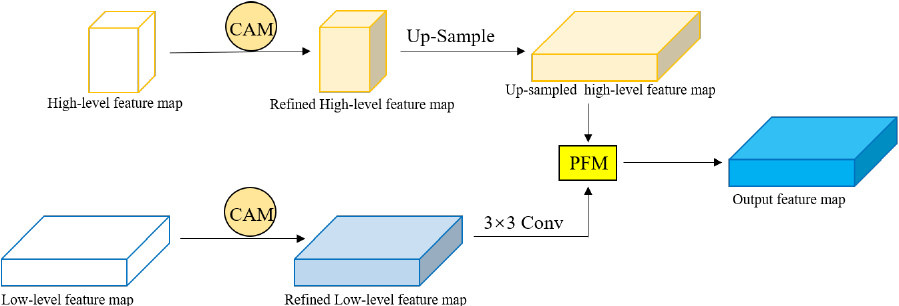
Figure 8. Specific structure of channel attention module decoder.